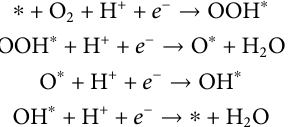
Frontiers in Chemistry |